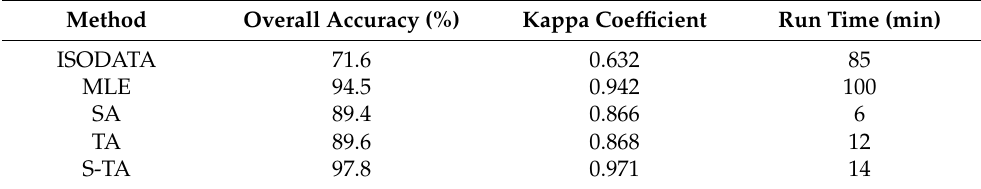
Table 5. The classification accuracy and efficiency of different methods for all stages.